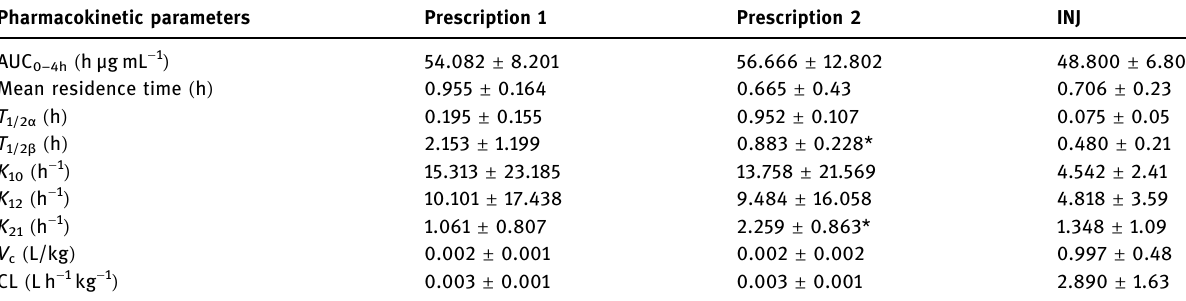
Table 5: Fitting to a two - compartment model